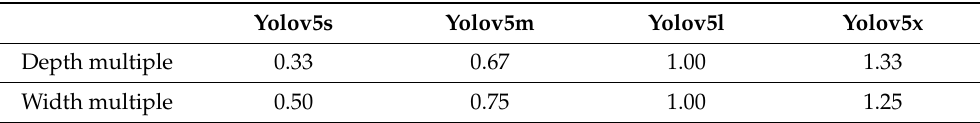
Table 2. The parameters of different Yolov5